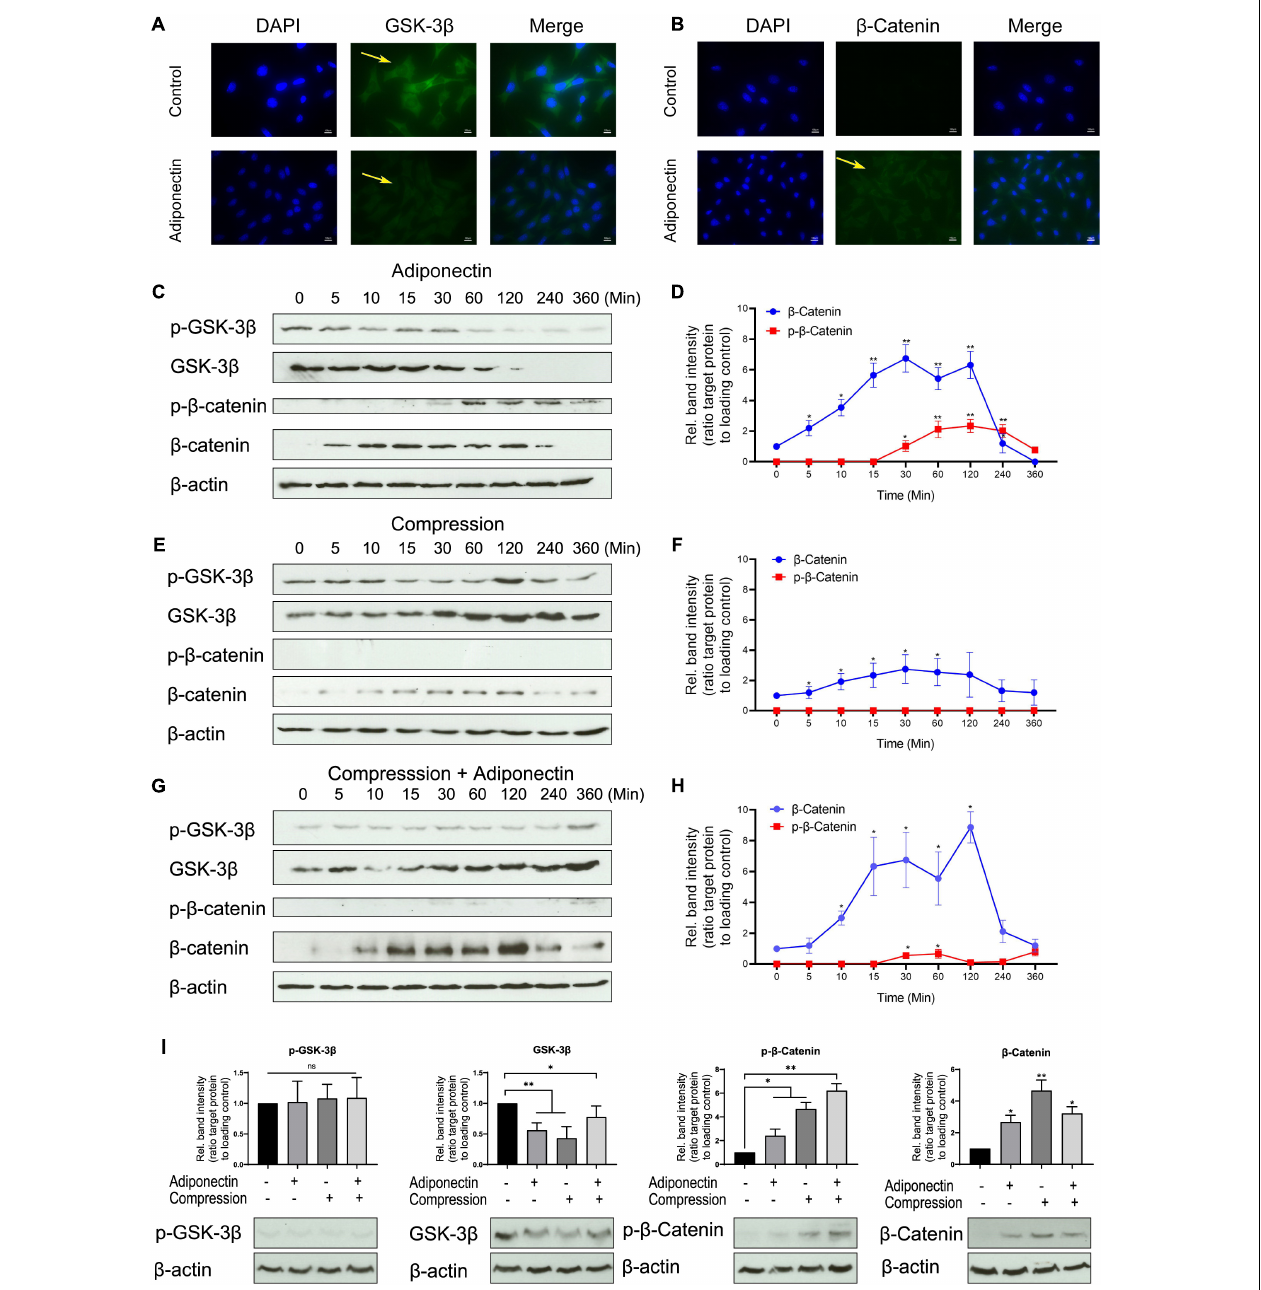
FIGURE 3 | The co-stimuli of adiponectin with compression enhance β -catenin expression on cementoblasts. (A,B) Immunofluorescence staining shows that adiponectin (100 ng/ml) decreases the expression of cytoplasmic GSK-3 β in OCCM-30 cells and the cellular β -catenin expression was increased after adiponectin (100 ng/ml) addition. (C,D) Western blots indicate that after adiponectin (100 ng/ml) addition to OCCM-30 cells, phosphorylated and total GSK-3 β protein expression decreased after 1 h, whereas the expression of total β -catenin increased from 5 min to 2 h due to adipokine stimulation. (E,F) Compressive forces exert a dual effect on OCCM-30 cells, increasing the expression of GSK-3 β as well as the levels of total β -catenin: western blots indicate that the expression of phosphorylated and total GSK-3 β as well as total β -catenin is increased after exposure to 2.4 gf/cm 2 compression for 0–6 h. (G,H) Compression in combination with adiponectin (100 ng/ml) enhances the expression of β -catenin: the kinetic analysis performed on OCCM-30 cells cultivated under 2.4 gf/cm 2 compression combined with adiponectin (100 ng/ml) shows that total β -catenin was significantly up-regulated after 10 min of stimulation over a period of 4 h. (I) Representative western blot showing the expression changes of GSK-3 β and β -catenin induced by adiponectin (100 ng/ml) in the presence or absence of compression (2.4 gf/cm 2 ). Graphic represents the protein intensity, which was quantified as ratio to loading control to show the protein expression of p-GSK-3 β , GSK-3 β , p- β -catenin, and β -catenin. Data were derived from three independent experiments. Values are expressed as means ± SD. Asterisks indicate significant differences compared to control cells at time point 0 (*** p < 0.001, ** p < 0.01, and * p < 0.05; ns, not significant).